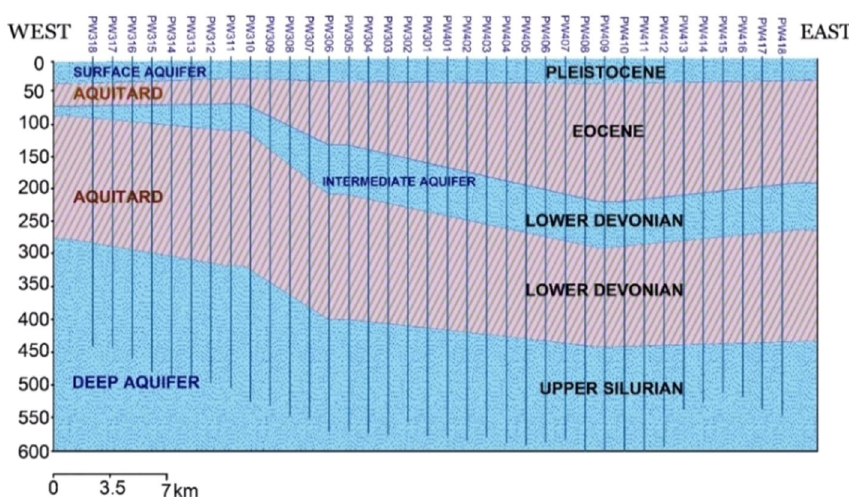
Fig. 4 Geological cross